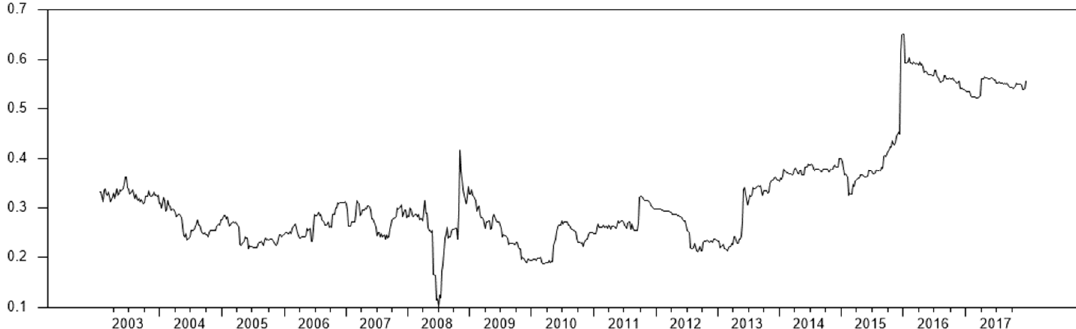
Figure 5. Dynamic correlation between the South African bond market and yen-funded carry trade returns.